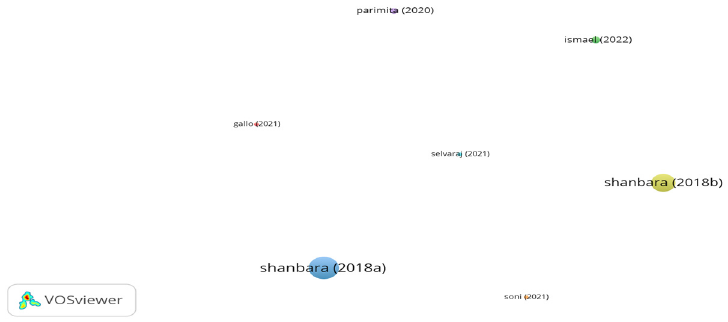
Figure 18. Network visualization of jute